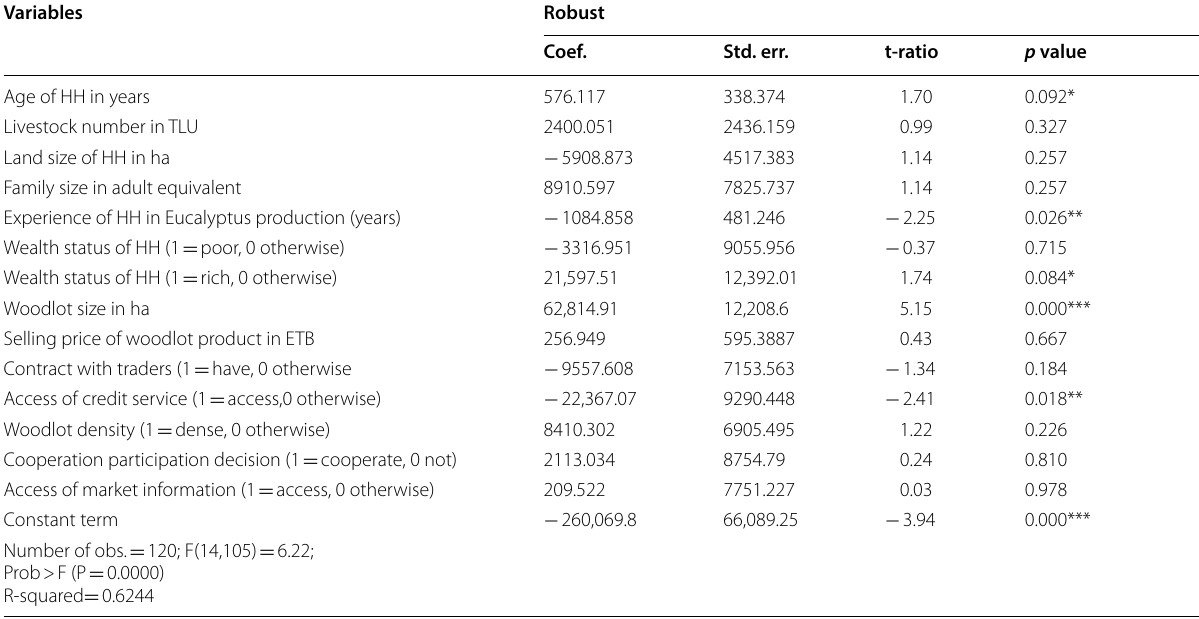
Dependent variable is commercial value of Eucalyptus woodlot products measured in ETB ***, ** and * shows the value statistically significant at 1%, 5% and 10% level, respectively